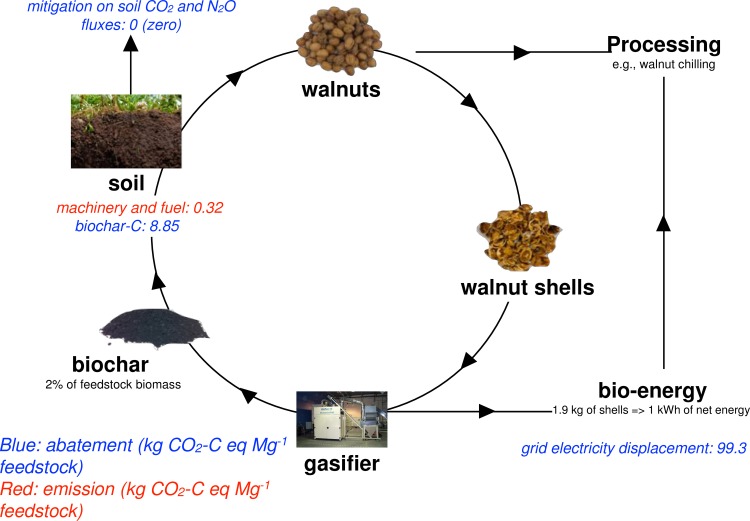
Illustration of the bioenergy-biochar production chain in a walnut farm and processing facility and the CO2 abatements and emissions associated to these activities.